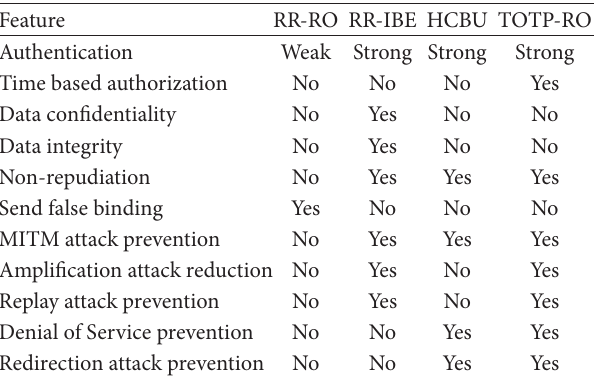
Table 1: Comparison of Route Optimization protocols for security